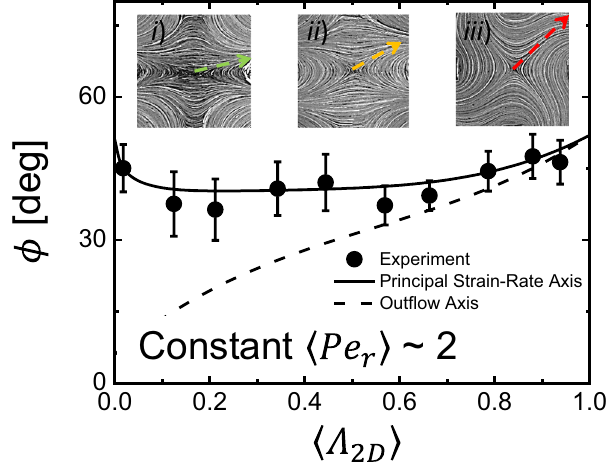
Figure 12. Absolute orientation of CNCs with respect to the q x direction, φ , from nearly shear ( Λ 2 D ~ 0) to nearly extensional ( Λ 2 D ~ 1) flow for a constant rotational Peclét number Pe r ~ 2. Lines indicate the absolute direction of the principal strain-rate axis (solid line), φ strain , and outflow axis, φ outflow determined from PTV (dotted line). The inset streakline images indicate φ outflow (dotted arrow) for ( i ) Λ 2 D = 0.03, ( ii ) Λ 2 D = 0.37, and ( iii ) Λ 2 D = 0.92. Error bars for φ correspond to the 68% confidence interval from the nonlinear least squares fit of equation